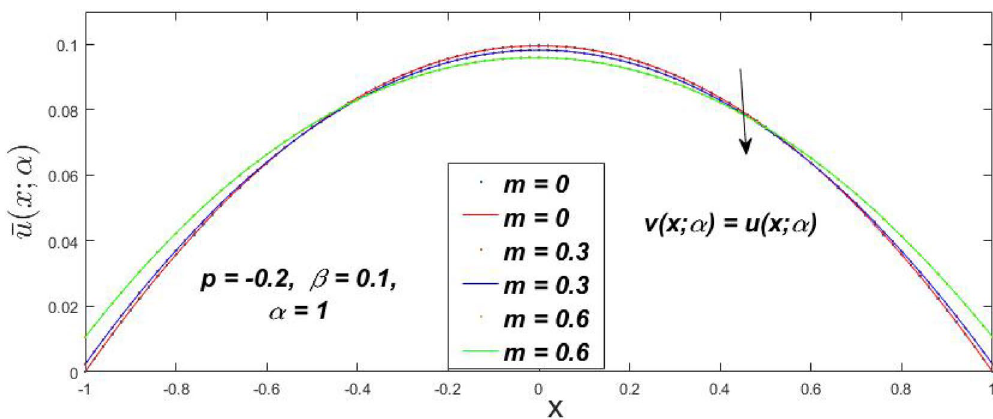
Figure 23. Fuzzy velocity profiles for the impact of m.